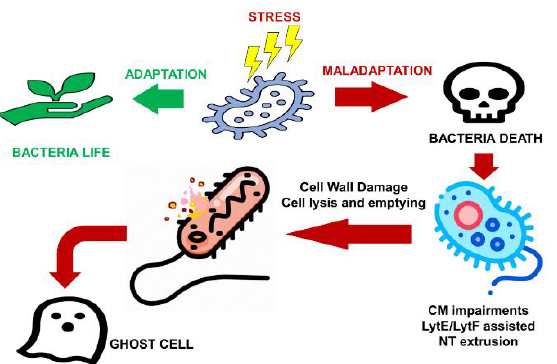
Figure 11. Model of BNTs formation (CM = cytoplasmic membrane; LytE and LytF = autolysins.